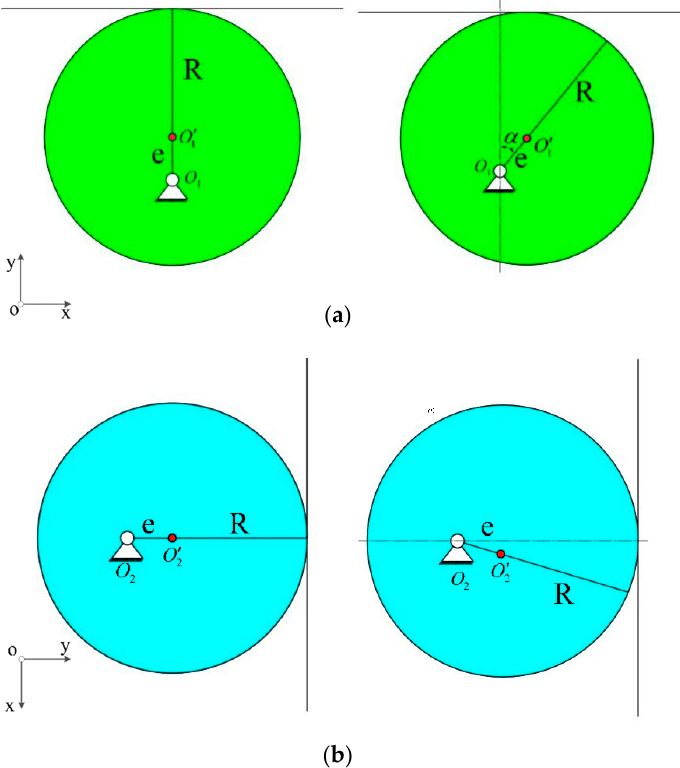
Figure 11. ( a ) The position of the eccentric wheel 1; ( b ) the position of the eccentric wheel